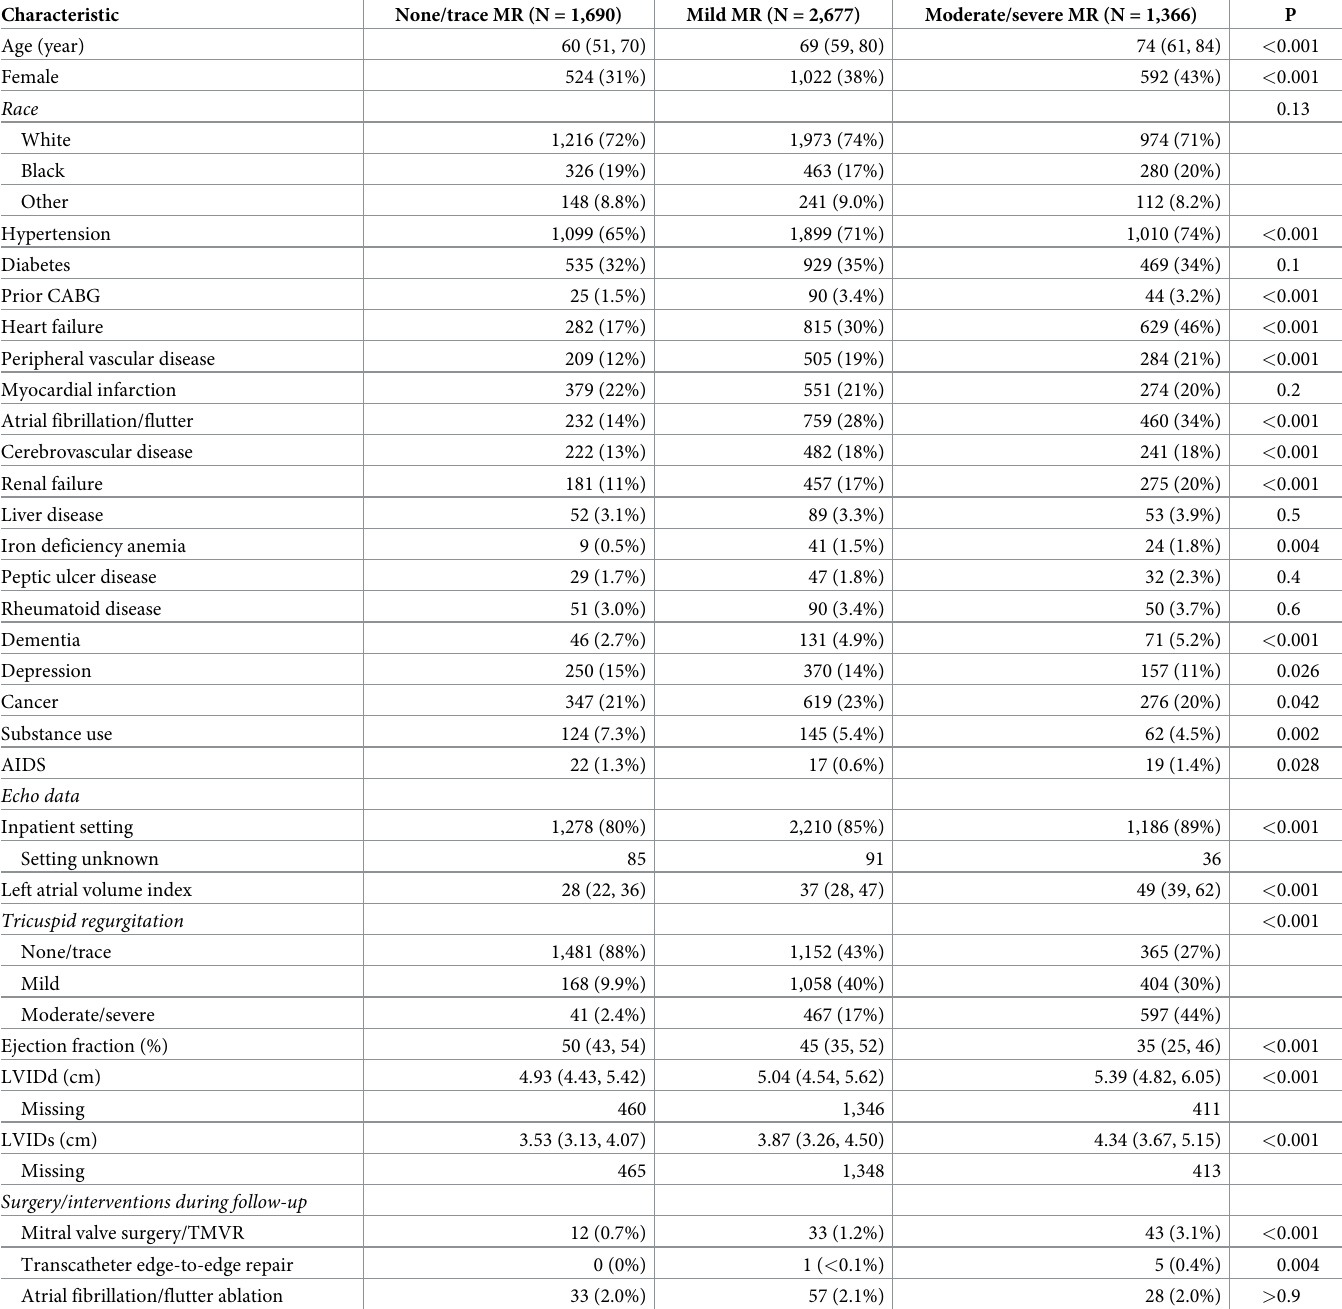
Table 3. Characteristics of patients with ventricular dysfunction by the SMR